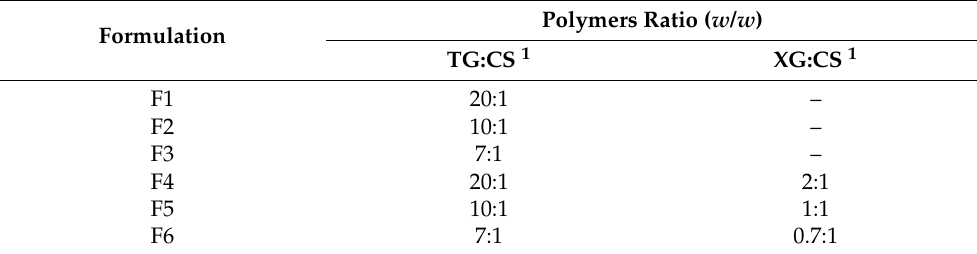
Table 1. Composition of the